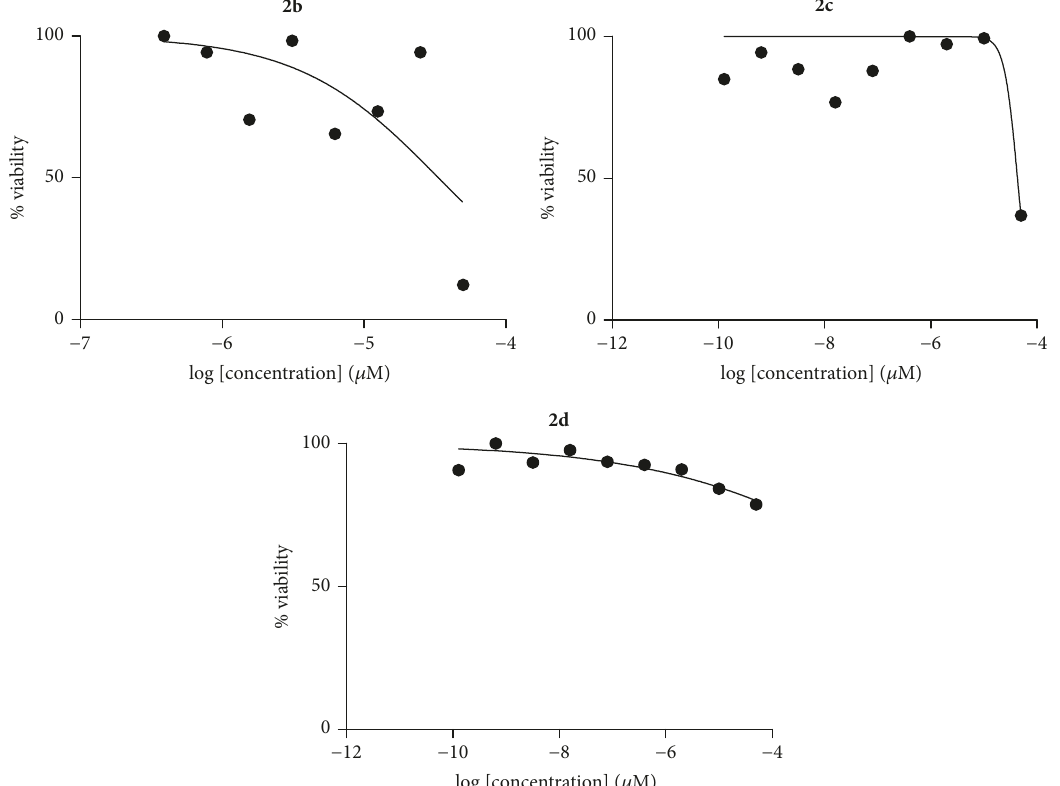
Figure 1: Cell viability of NPC cells, HK1 treated with 1a–d and 2a–d , aspirin, and standards (cisplatin and 5-fluorouracil).